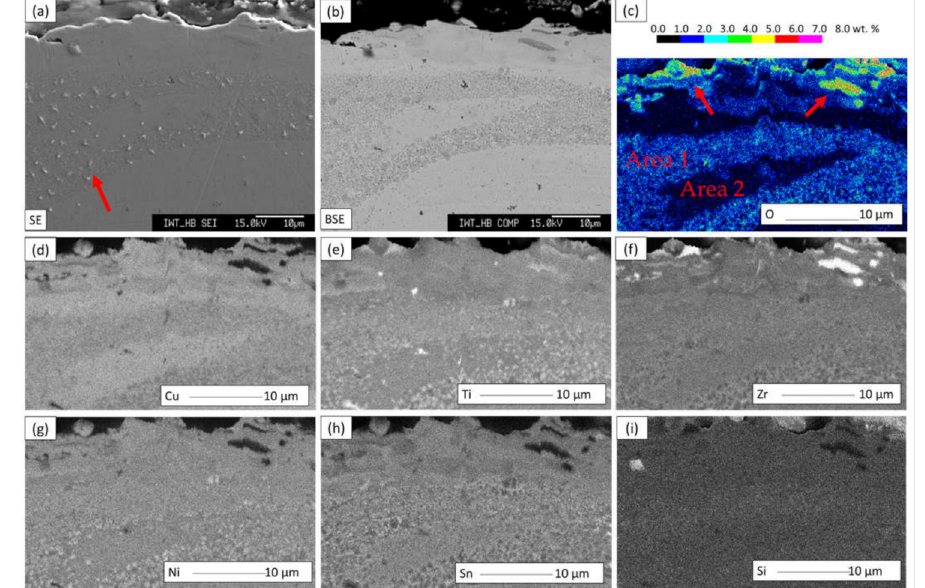
Figure 5. EMP results of the LPBF sample after the corrosion investigation including: ( a ) SE micro- graph; (b ) BSE micrograph; and the elemental mapping distribution of ( c ) O, ( d ) Cu, ( e ) Ti, ( f ) Zr, ( g ) Ni, ( h ) Sn, and ( i ) Si. The arrow in ( a ) indicates a preferential area for the formation of precipitates. It occurs at an oxygen-rich region (area 1) as seen in ( c ). The arrows in ( c ) point out the highest concentration of oxygen detected, which coincides with the highest concentration of Zr, as seen in ( f ), suggesting the possible formation of local crystalline